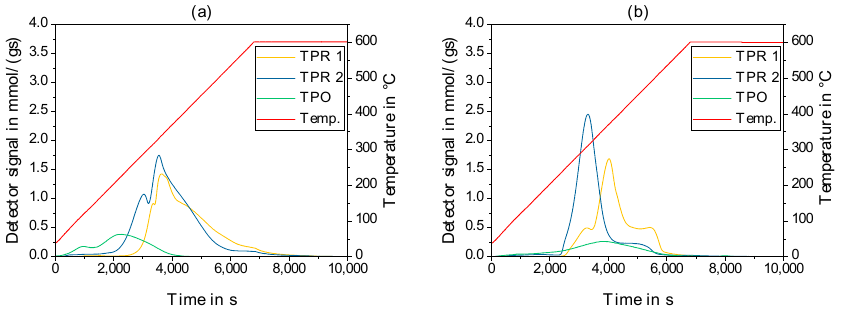
Figure 7. Results of TPROR measurements up to 600 °C: ( a ) Cobalt-silica system with two signal maxima of the second TPR at about 290 °C and 330 °C. ( b ) Nickel-silica system with one signal maximum of the second TPR at approx. 310 °C.